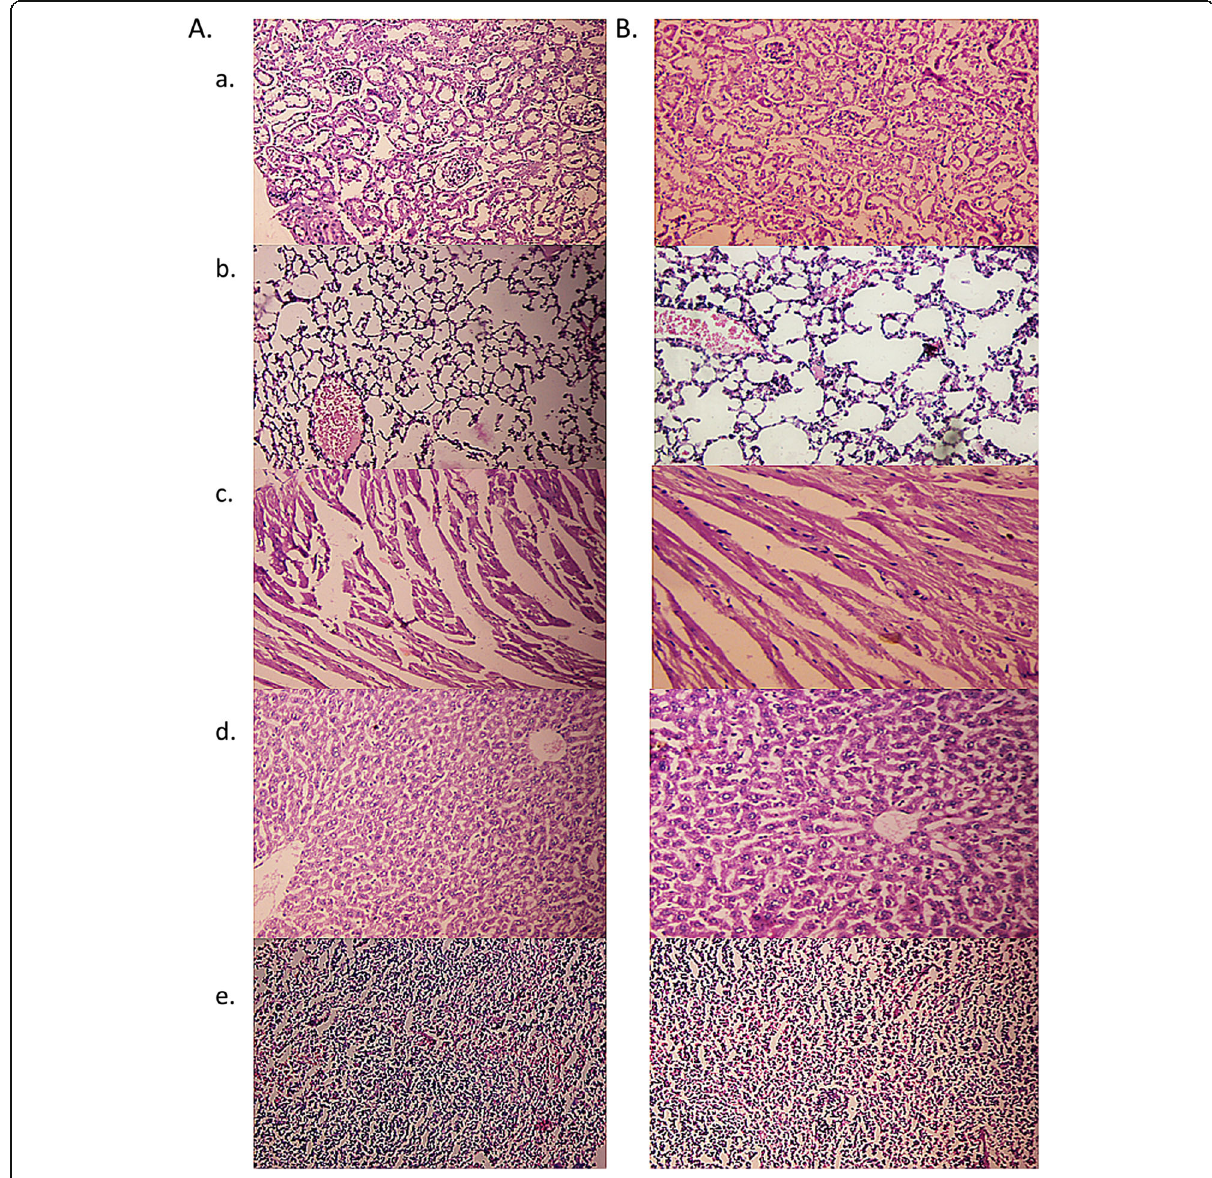
Fig. 7 Histopathology of organs taken from a Control and b MEUP-treated groups. Tissue sections of (a) kidney, (b) lung, (c) heart, (d) liver, and (e) spleen observed under a microscope (magnification × 10) showing no signs of toxicity to the vital